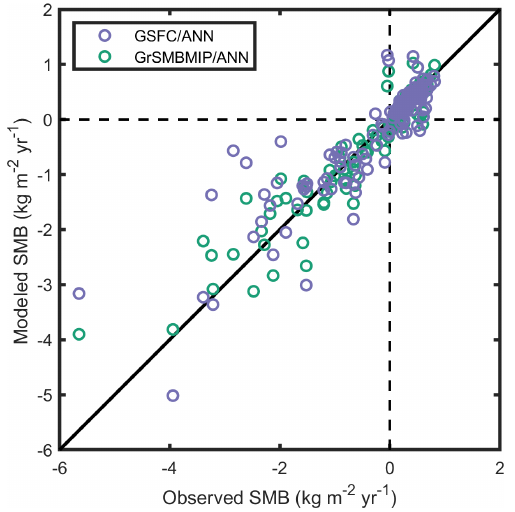
Figure 20. Comparison of SMB observations and the GSFC/ANN (purple) and GrSMBMIP/ANN (green) data sets for the GrIS (see Sect. 2.5.2 for the method).